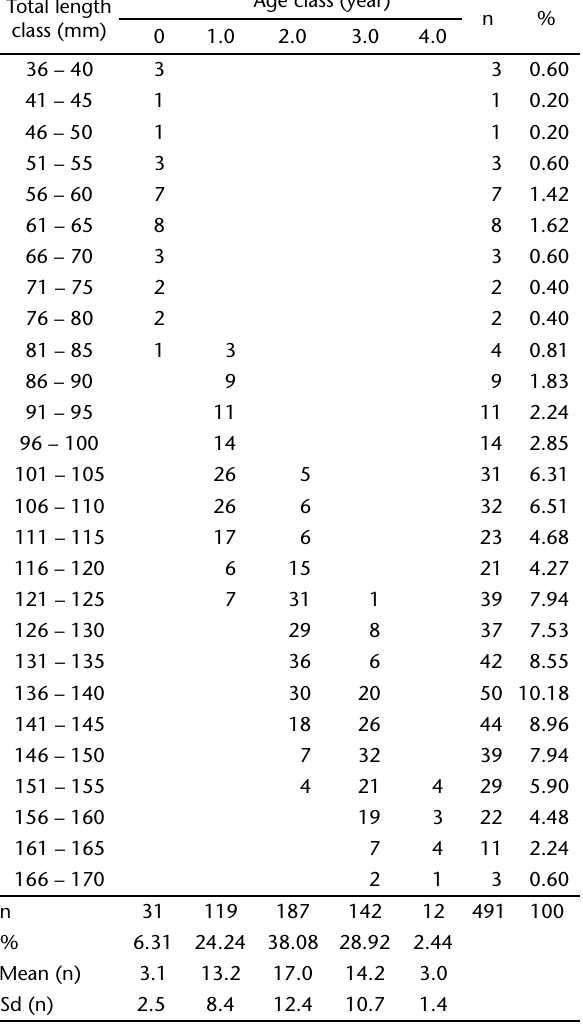
Table II. Age-length distribution obtained for C. edentulus in the Saco dos Limões bight (southern Brazil). Total length classes (mm), age classes (year), total number (n) and frequency (%) by classes are